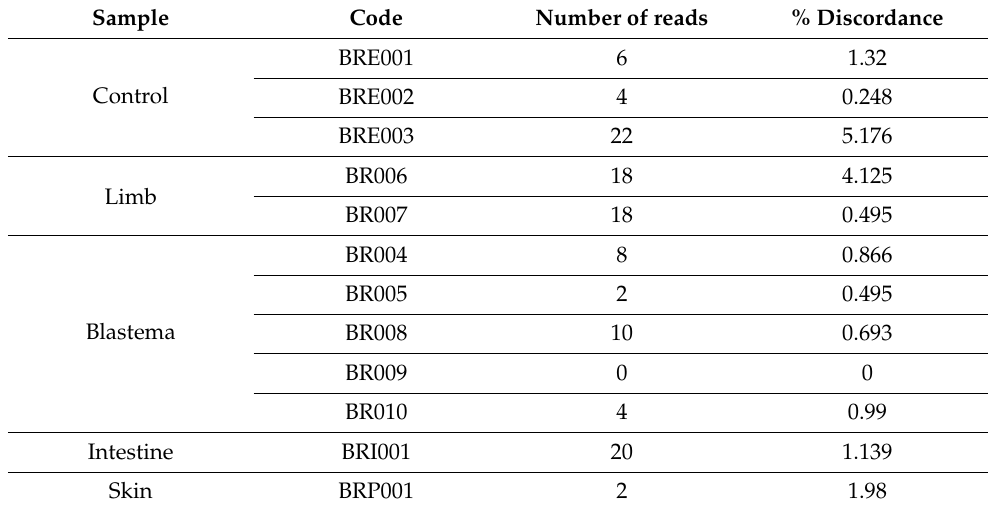
Table 3. Number of reads of the Ramosin peptide. Each of the samples used for de novo assembly of the B. ramosi transcriptome is shown. Control: limb samples at the time of amputation, Limb: tissue after regeneration, Blastema: tissue in the process of